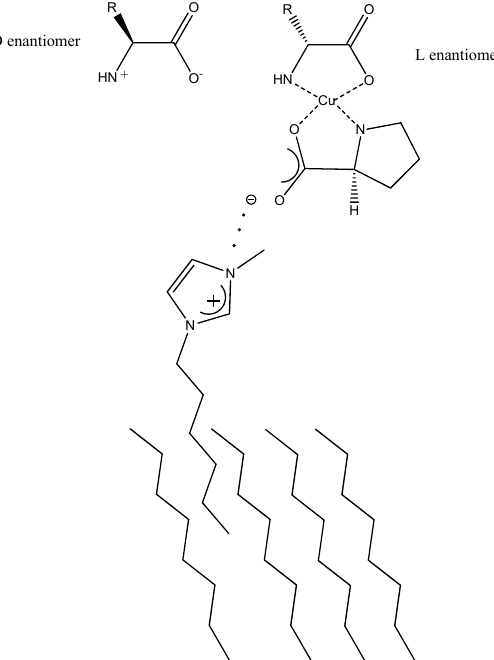
Figure 17. Retention mechanisms of (Cu(AAIL) ( l -amino acid) complexes on the high-performance liquid chromatography (HPLC) column. Dots between l -Pro and alkylimidazolium cations represent formation of ion pairs (adapted from Liu, 2009)